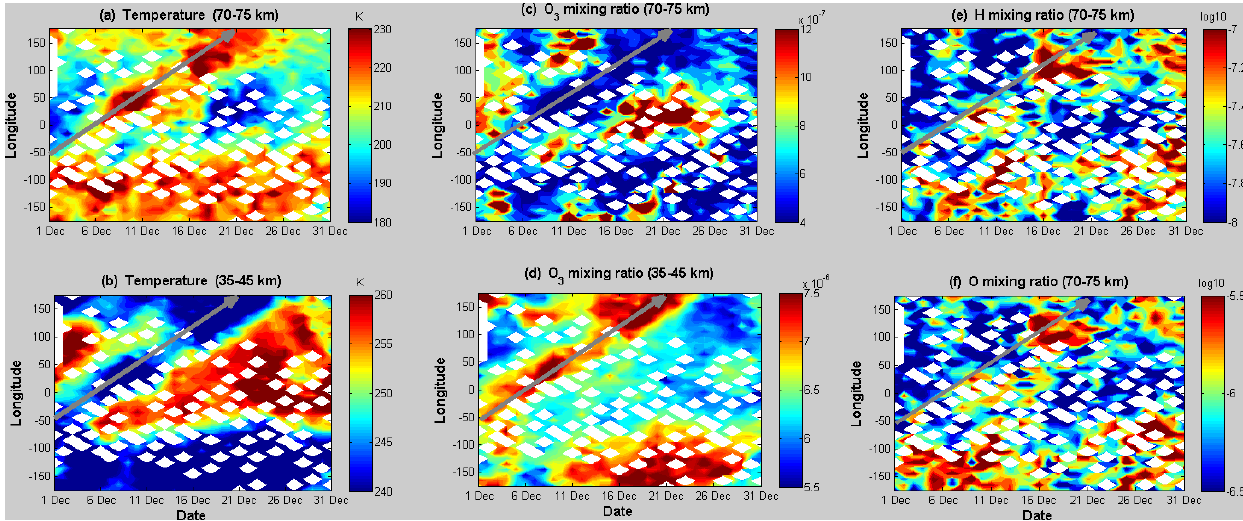
Figure 5. (a–d) The temporal variations of temperature and O 3 with longitude averaged over 35–45 ◦ N and in the altitude range of 70–75 and 35–45km, respectively. (e–f) The daily variations of atomic H and O with longitude, averaged over 35–45 ◦ N and in the altitude range of 70–75km,